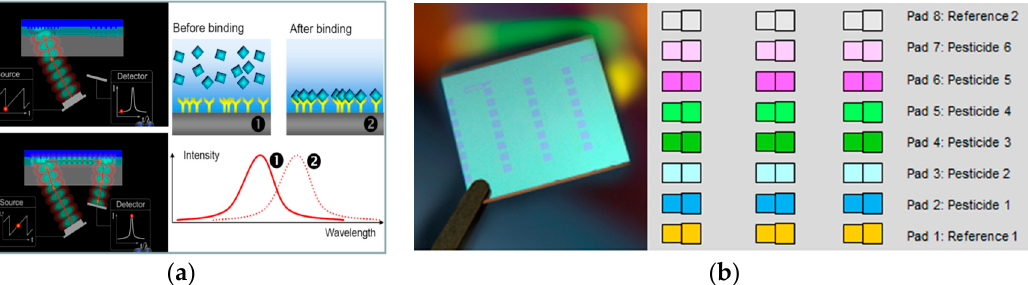
Figure 1. WIOS chip design and layout. ( a ) optical scheme showing the incoming tunable light from the VCSEL, the detection photodiode, and the structure of the waveguide chip with the gratings; a flow cell is mounted on top of the waveguide and allows flowing the liquid sample; ( b ) waveguide chip with the flow path of the liquid over the eight measurement pads, and sensing chip surface for the detection of up to 6 pesticides in